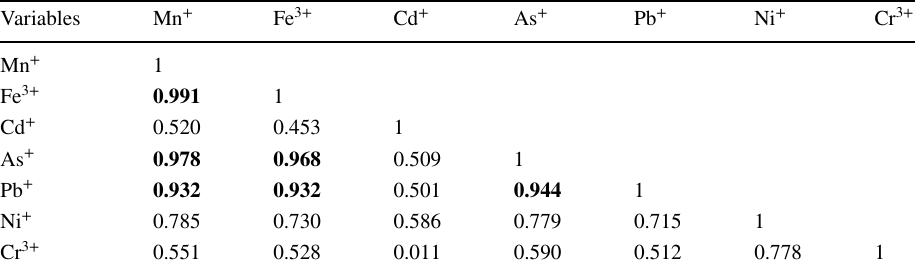
Values in bold correspond to very strong direct relationship between two variables (R²